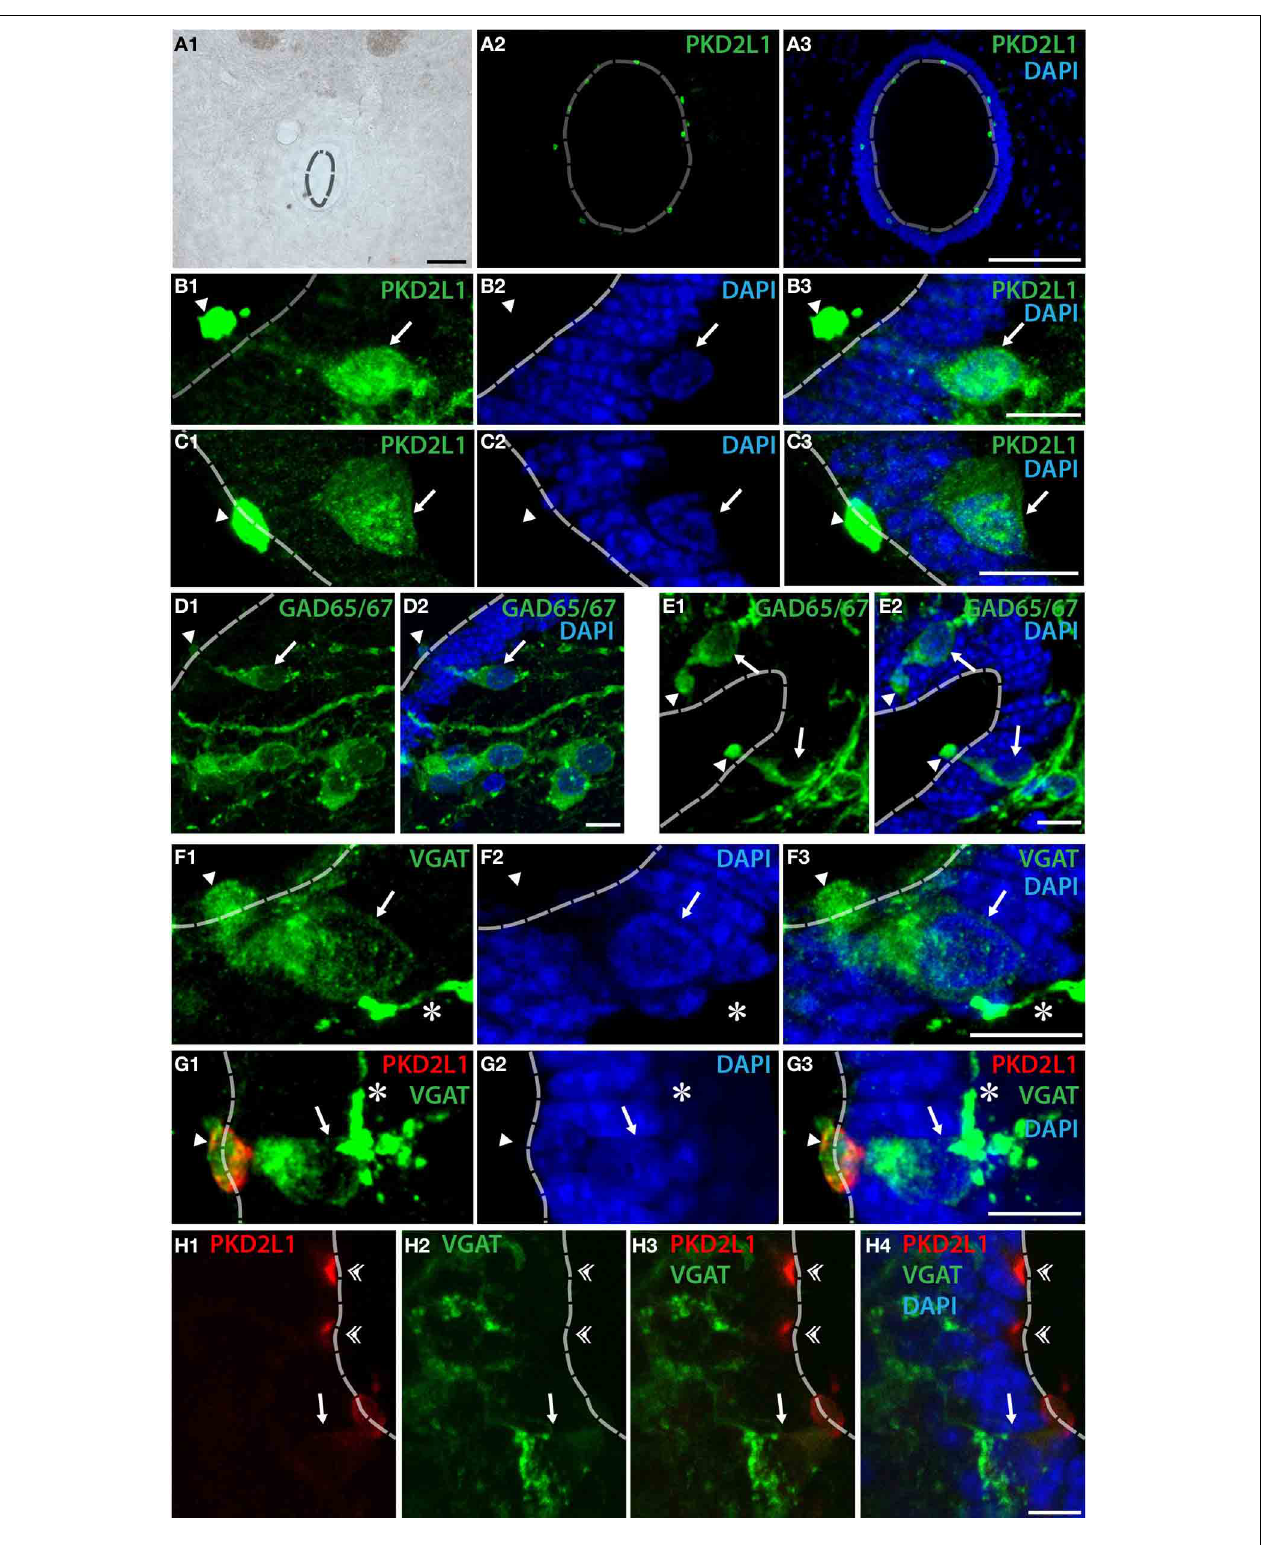
FIGURE 3 | PKD2L1 + CSF-cNs can be found as GABAergic neurons surrounding the central canal in the spinal cord of the adult macaque. (A–C) PKD2L1 immunostaining labels intraluminal buds (A–C) and rarely subependymal or ependymal cell bodies (B,C). (D,E) GAD65/67